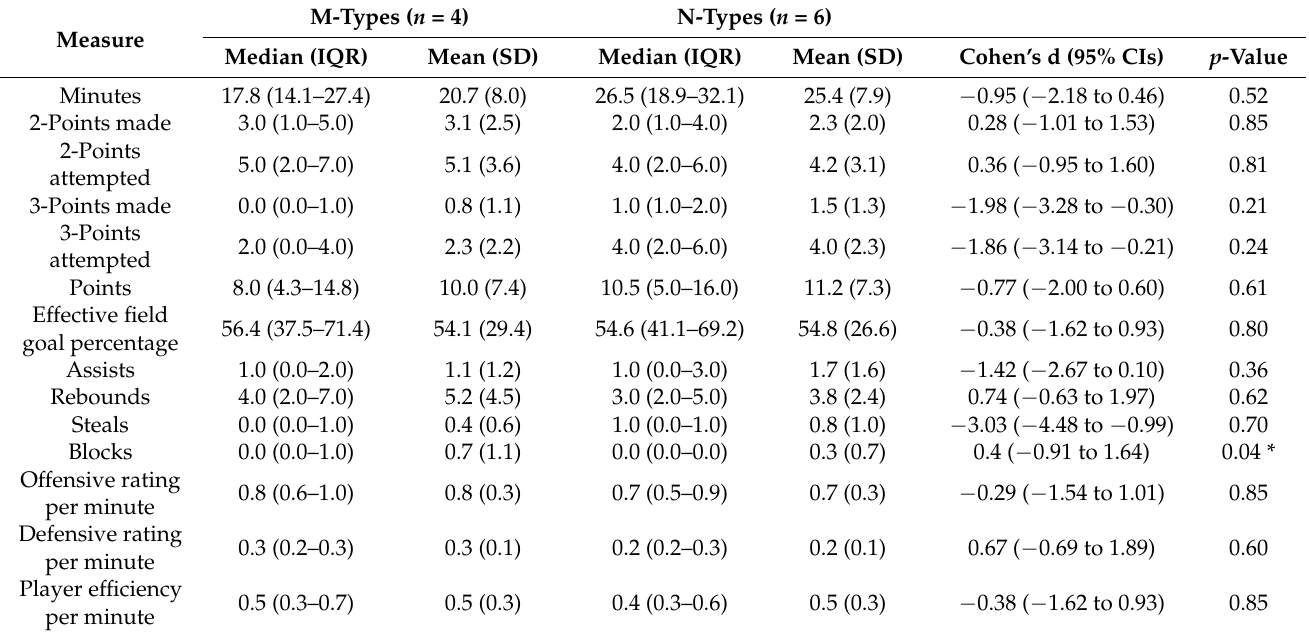
Table 1. Median (inter-quartile range) values mean (standard deviation) and comparison statistics between morning-types (M-types) and neither-types (N-types) for in-game performance measures during evening games in professional male basketball